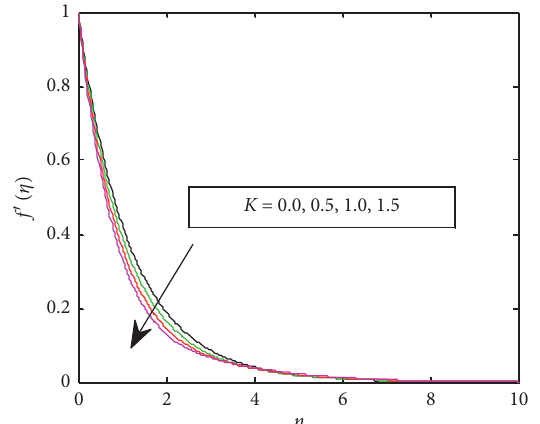
Figure 14: Velocity distribution for different values of mixed convection parameters.